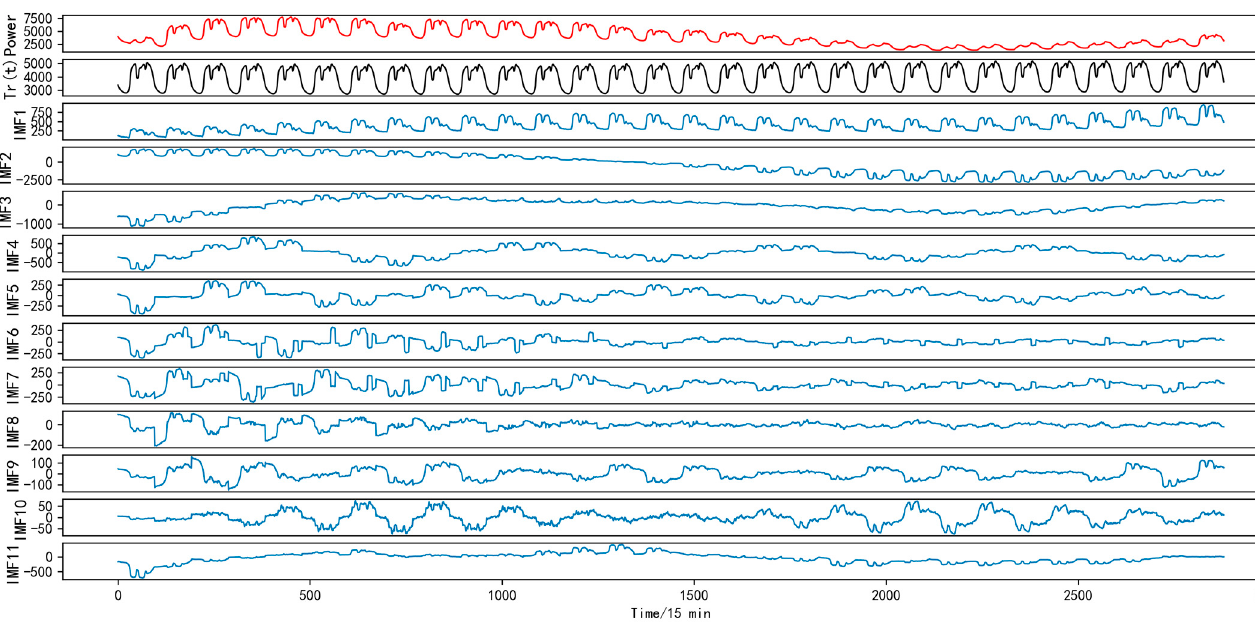
Figure 12. Area 1 VMD results.